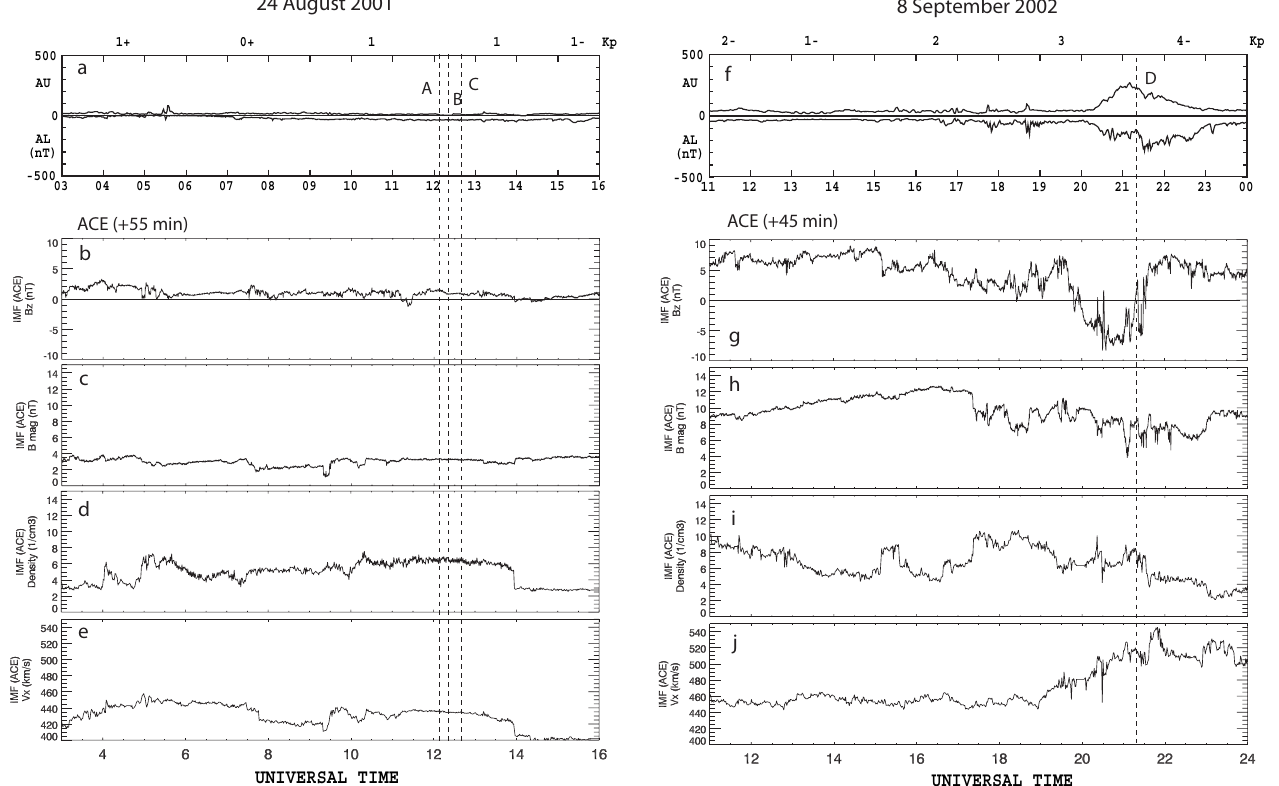
Fig. 5. Solar wind/IMF data and geomagnetic indices to assess the global state of the magnetosphere before and during the events on 24 August 2001 and 8 September 2002. The vertical dashed lines mark the event onsets. (a) , (f) K p , AU and AL indices from the WDC